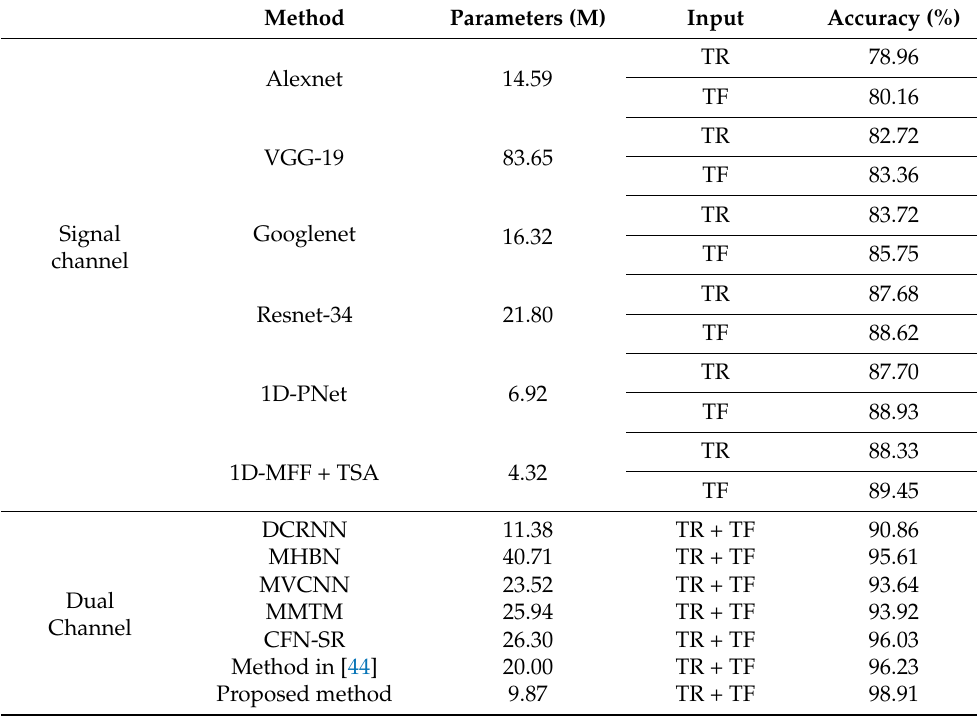
Table 2. Performance comparison of various methods.